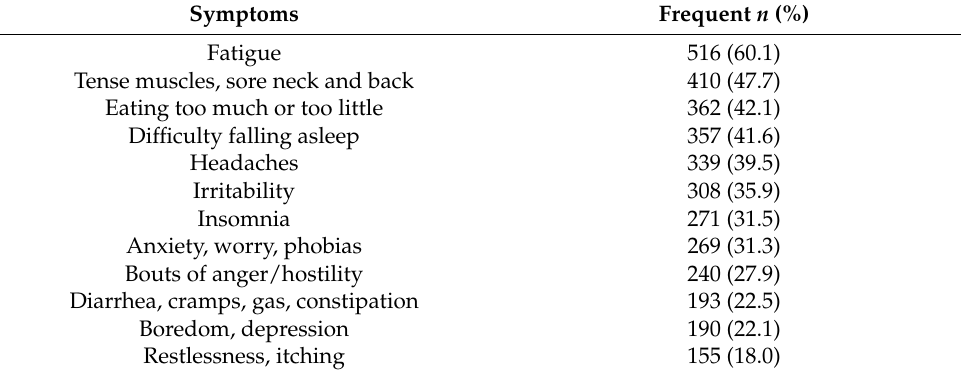
Table 3. Stress Symptoms (N =